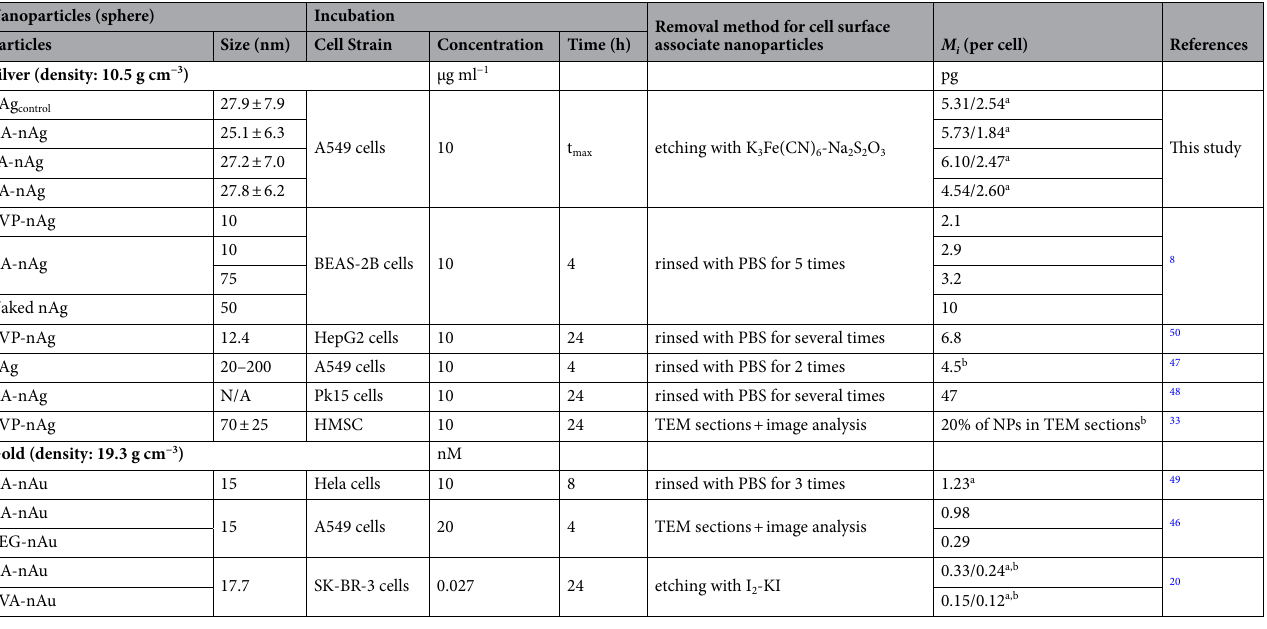
Table 5. Summarizing of M i of AgNPs and AuNPs in reported literature. N/A no data, PEG polyethylene glycol, PVA polyvinyl alcohol. a Before/after etching. b Data acquired from scaling the Figures panel in related